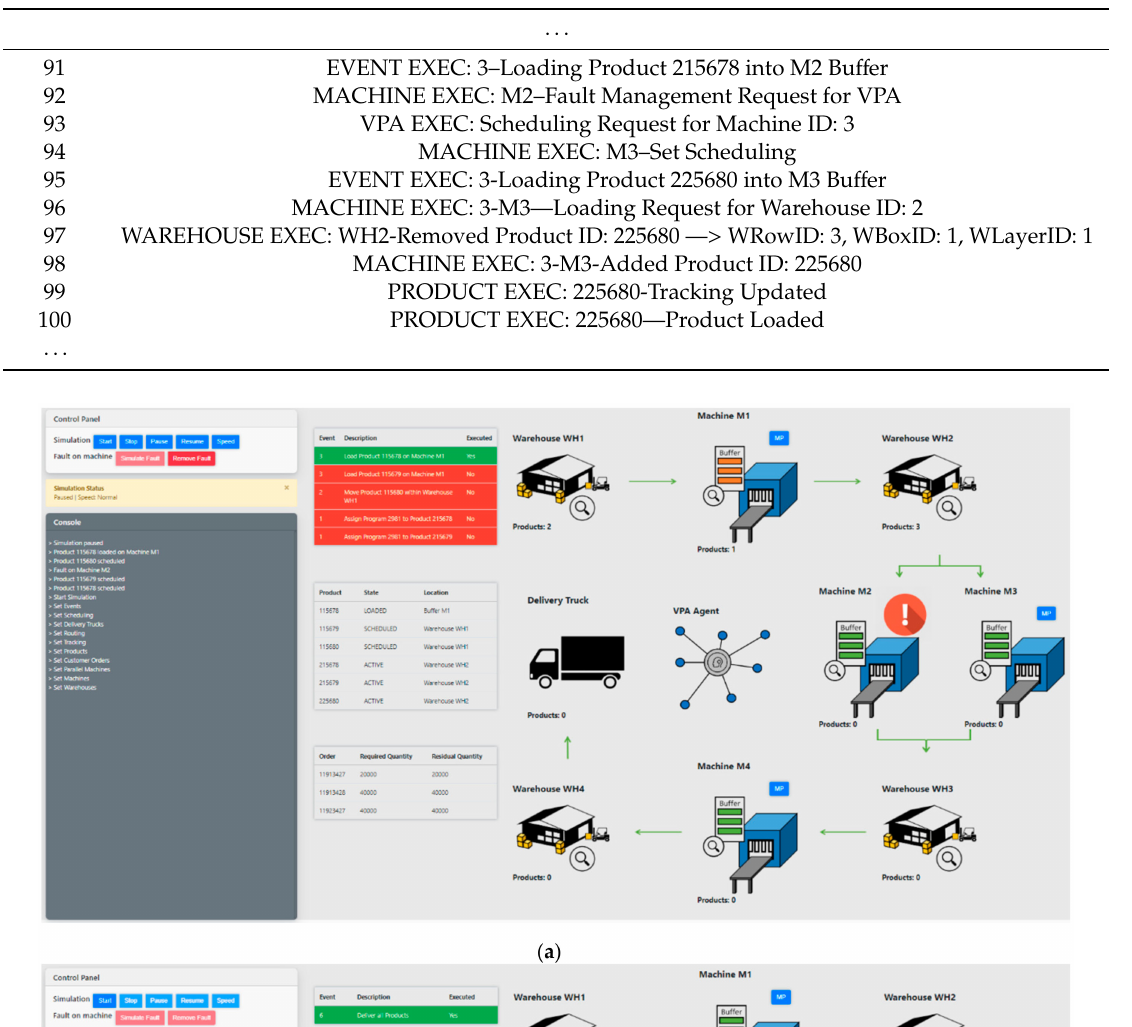
Table 8. Extract of simulation log with the messages of the agents related to the Machine Fault Scenario.